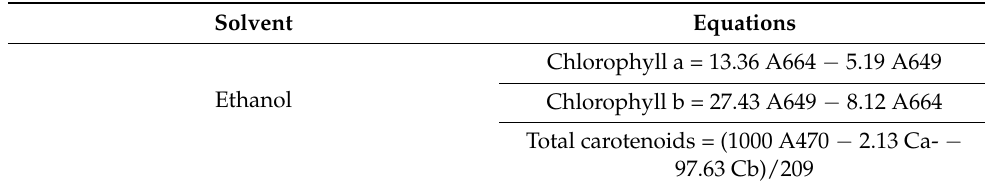
Table 1. Equations to determine concentrations ( µ g/mL) of chlorophyll a, chlorophyll b, and total carotenoids from ethanol extract of